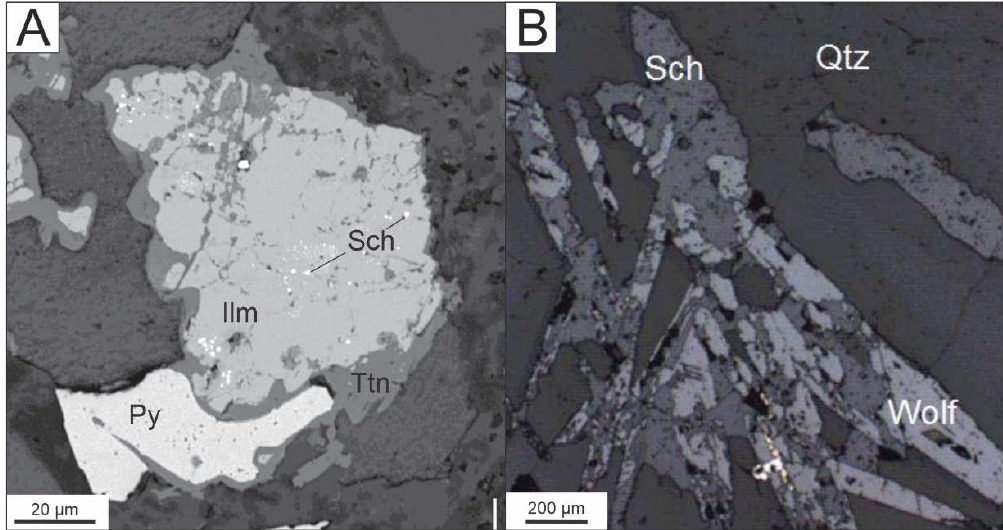
Figure 4. Mineralization at the Sisson Brook deposit. ( A ) SEM-BSE image showing μm scale scheelite (Sch) inclusions in metasomatic ilmenite (Ilm), which is rimmed by titanite (Ttn). Host rocks are dominated by quartz and biotite. Anhedral pyrite (Py) is also rimmed with titanite. Sample from drill core SB0806 at 69 m. ( B ) Relationship of scheelite (Sch) and wolframite (Wolf), with scheelite replacing blades of wolframite in a quartz (Qtz) vein in tuff. Sample from drill core SB0917 at 29 m.